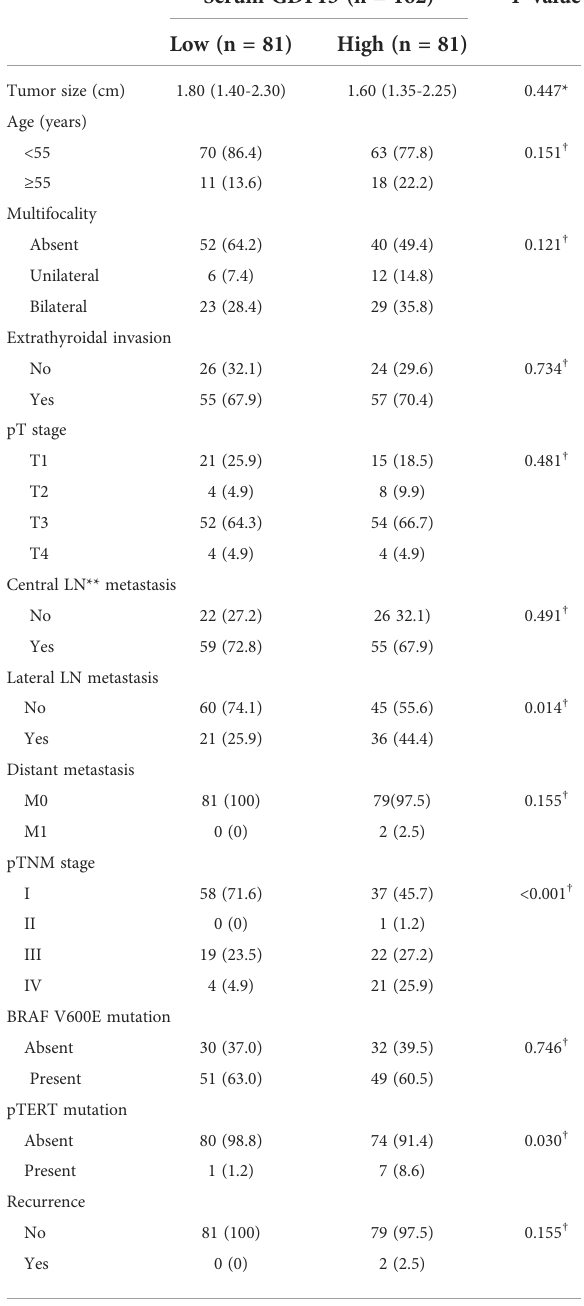
TABLE 1 Relationship between serum GDF15 level and clinico- pathological features of patients with